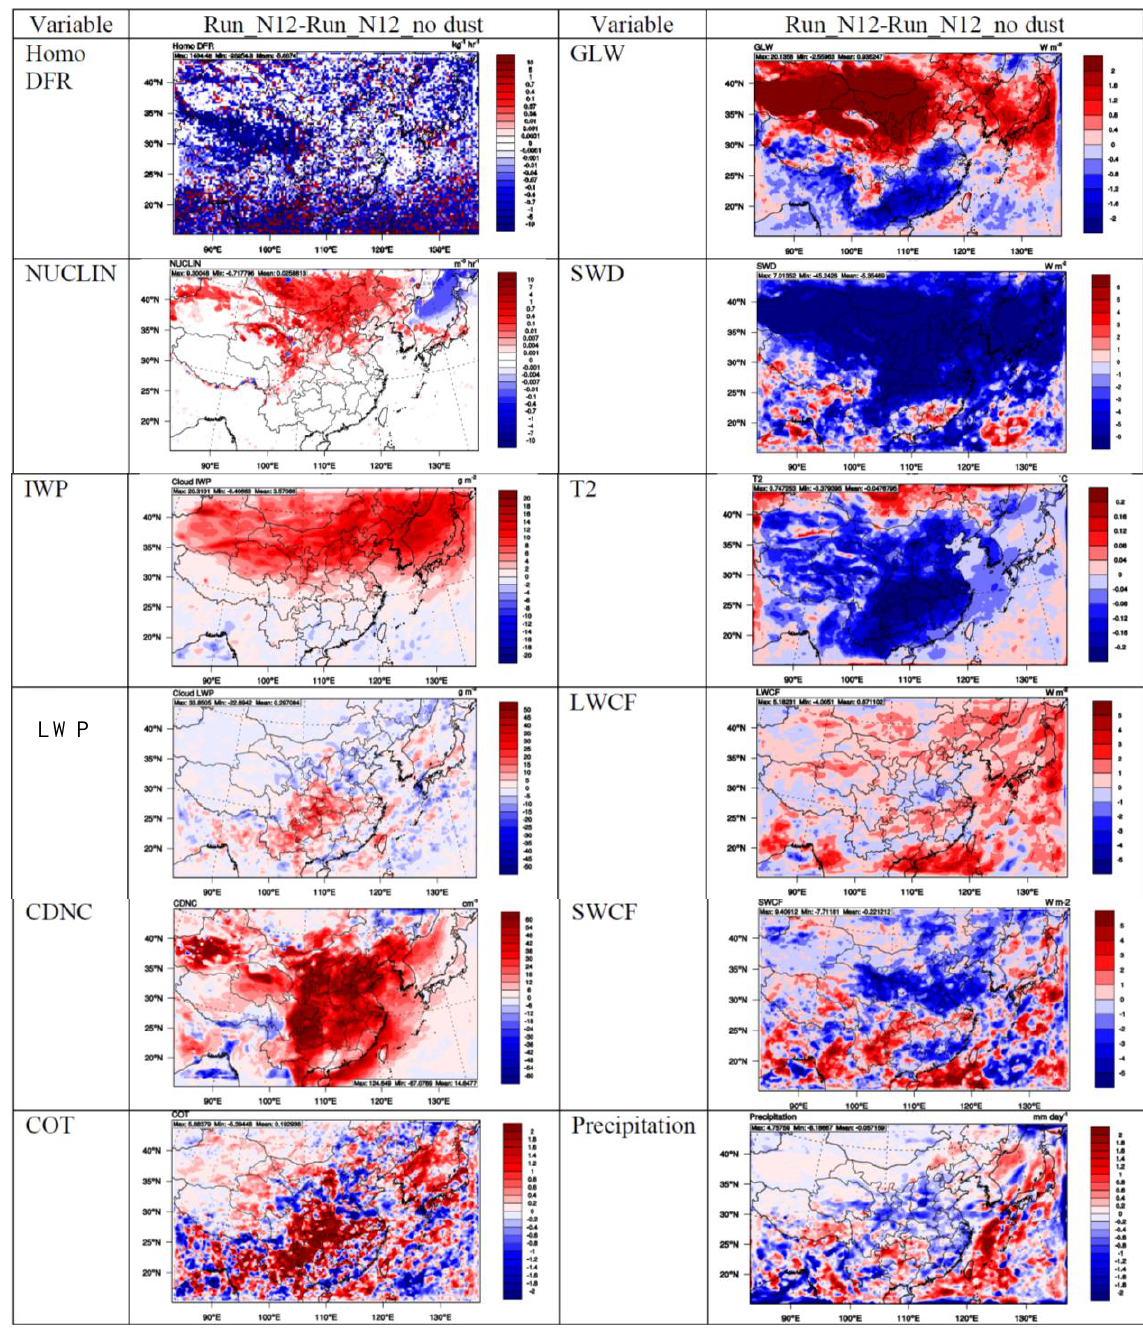
Figure 9. Spatial distributions of absolute differences of Homo DFR, NUCLIN, IWP, LWP, CDNC, COT, GLW, SWD, T2, LWCF, SWCF, and precipitation between Run_N12 (with Z03 dust emission scheme) and Run_N12_no dust (without natural dust